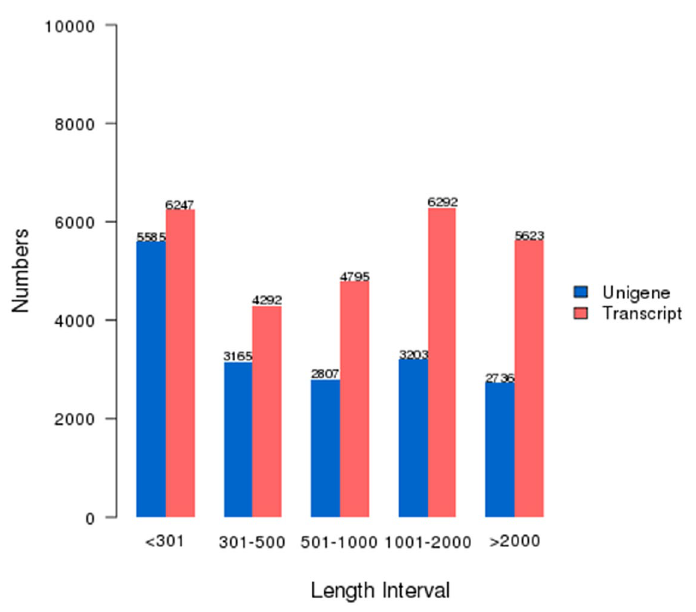
Figure 1. The transcript and unigene length distribution of P. polysora